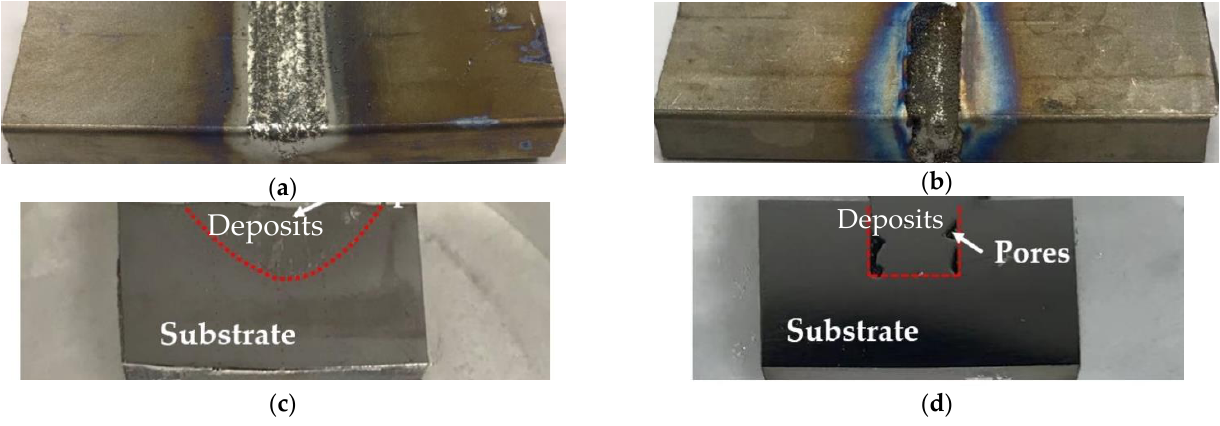
Figure 3. Repaired substrates with triangular ( a ) and rectangular ( b ) slots; overview of the cross-section of the repaired substrates with triangular ( c ) and rectangular ( d ) slots.